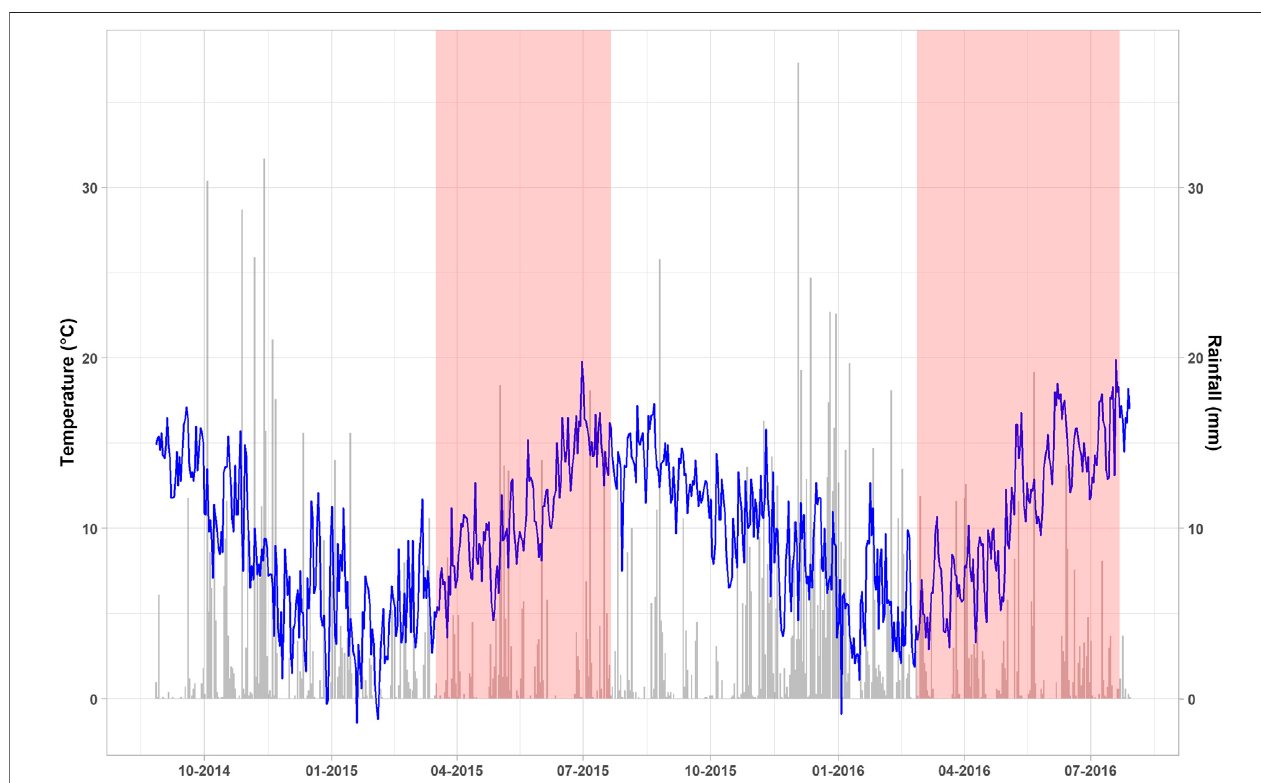
FIGURE3| SoilCO 2 ef fl uxaftertheinitialsoilcultivation eventforconventionaltillage(CT),strip tillage(ST)andminimumtillage(MT)over a12-dayperiod.Theinset plot illustrates the soil CO 2 ef fl ux of CT, ST and MT up to 5 h after the initial soil cultivation.